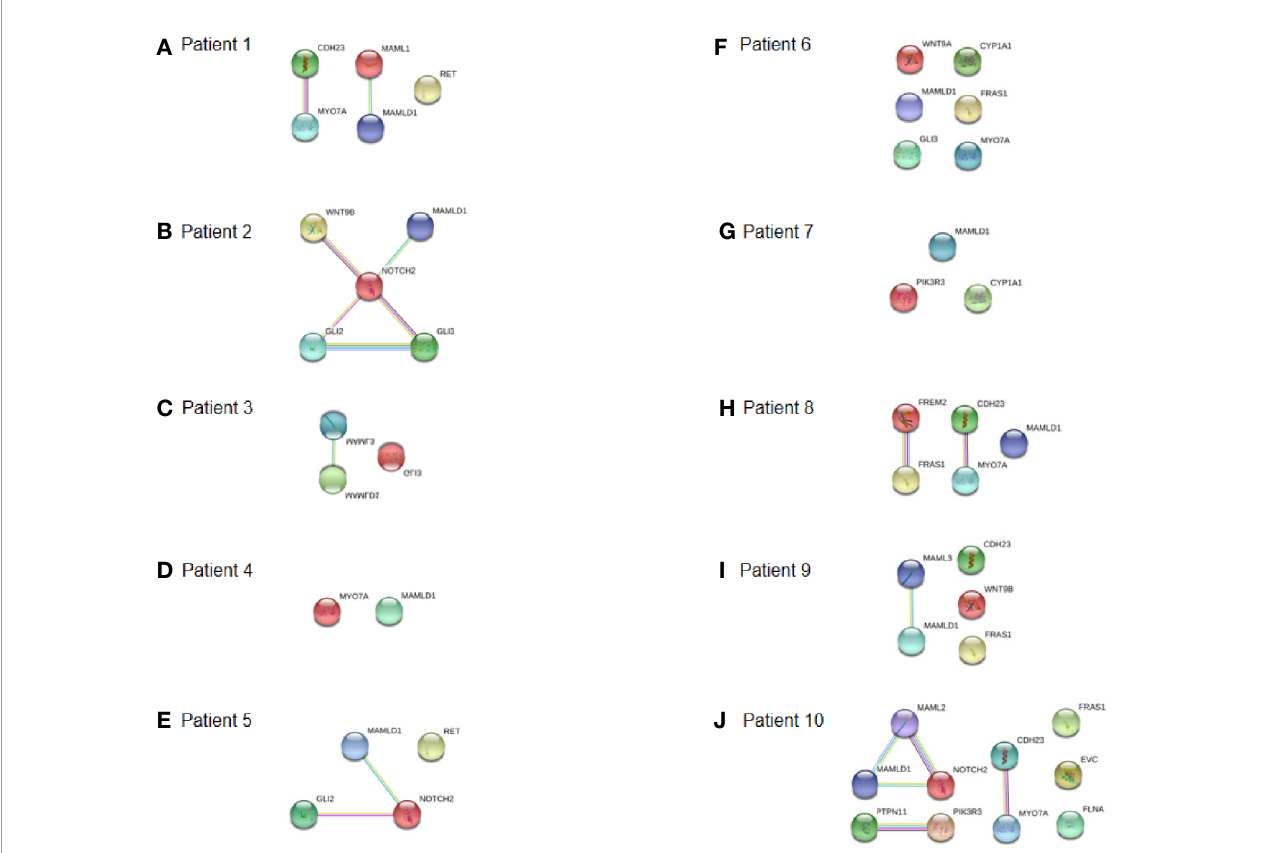
FIGURE 5 | Interaction networks of DSD- and MAMLD1-related genes identi fi ed per MAMLD1 individual. (A) to (J) correspond to the interaction networks per patient. Filled nodes show proteins with known or predicted 3D structure. Empty nodes depict proteins with unknown 3D structure. Candidate genes are underlined. Known interactions correspond to curated databases (turquoise lines) and experimentally determined interactions (pink lines). Predicted interactions correspond to gene neighborhood (green lines), gene fusions (red lines) and gene co-occurrence (blue lines). Other interactions correspond to text mining (yellow lines), co- expression (black lines) and protein homology (violet